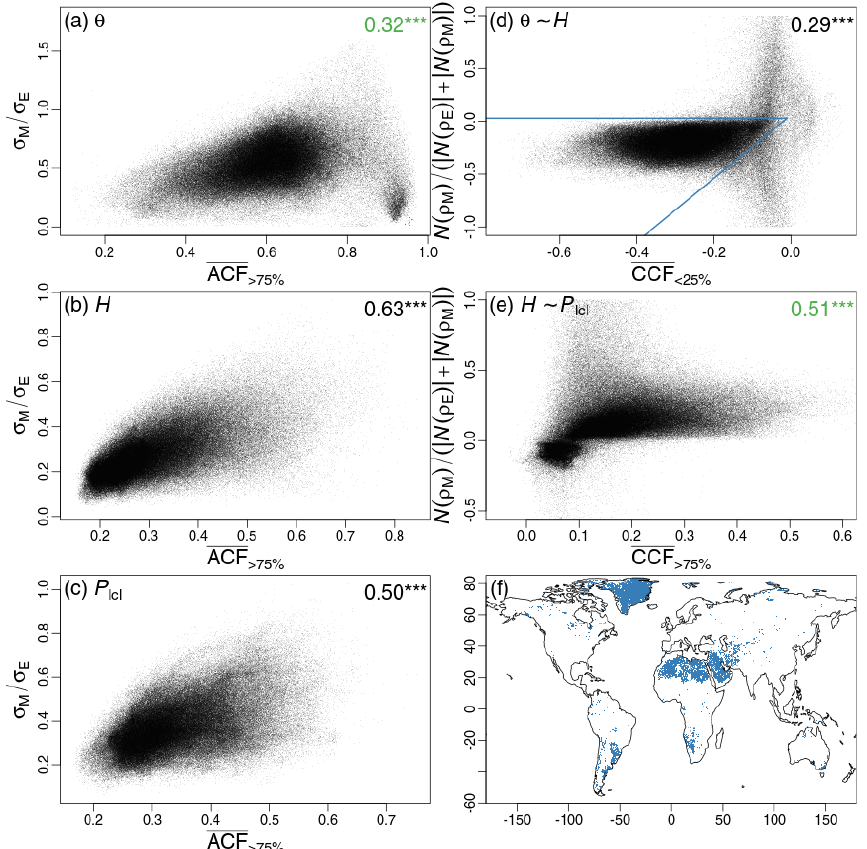
Figure 3. Scatterplot of coupling signal loss rate when moving from TLM E to TLM M as a function of an indicator reflecting the memory of L–A states. Points represent terrestrial grid cells around the globe. (a–c) Loss rate of the σ term as a function of averaged autocorrelation function (ACF) with a quantile larger than 75% (see Sect. 2.4). (d–e) Loss rate of the numerator of the ρ term (see Sect. 2.4) as a function of averaged cross-covariance function (CCF) within a certain quantile range (shown by the subscript, see Sect. 2.4). Dark and green values at the top right are Pearson and Spearman correlation coefficients for linear and nonlinear relationships, respectively. ∗∗∗ indicates p < 0 . 001. (f) Patterns with values out of the main cluster (separated by two blue lines) are in (e)